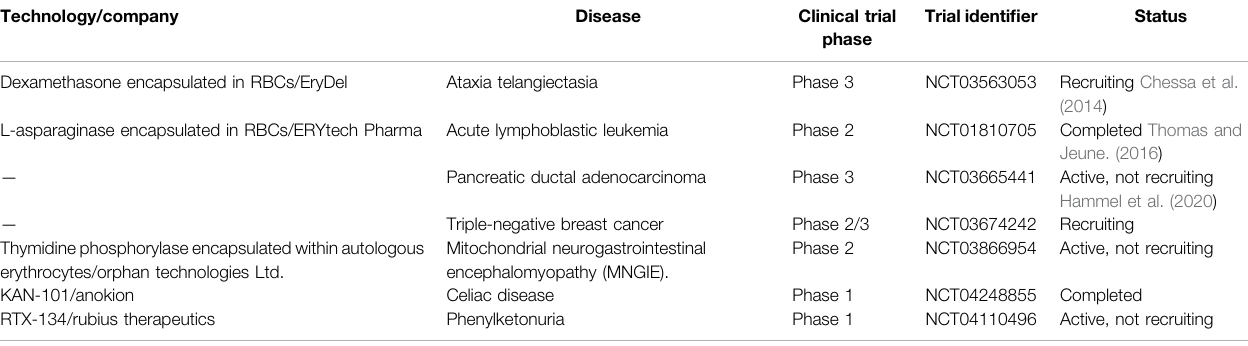
TABLE 2 | Overview of clinical trials of various RBC-based formulations (Source: